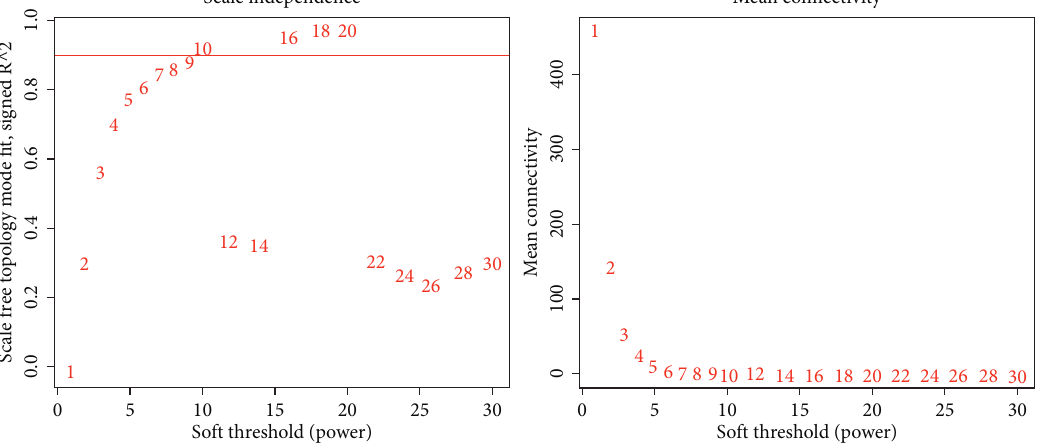
Figure 4: Distribution of threshold and average connectivity.